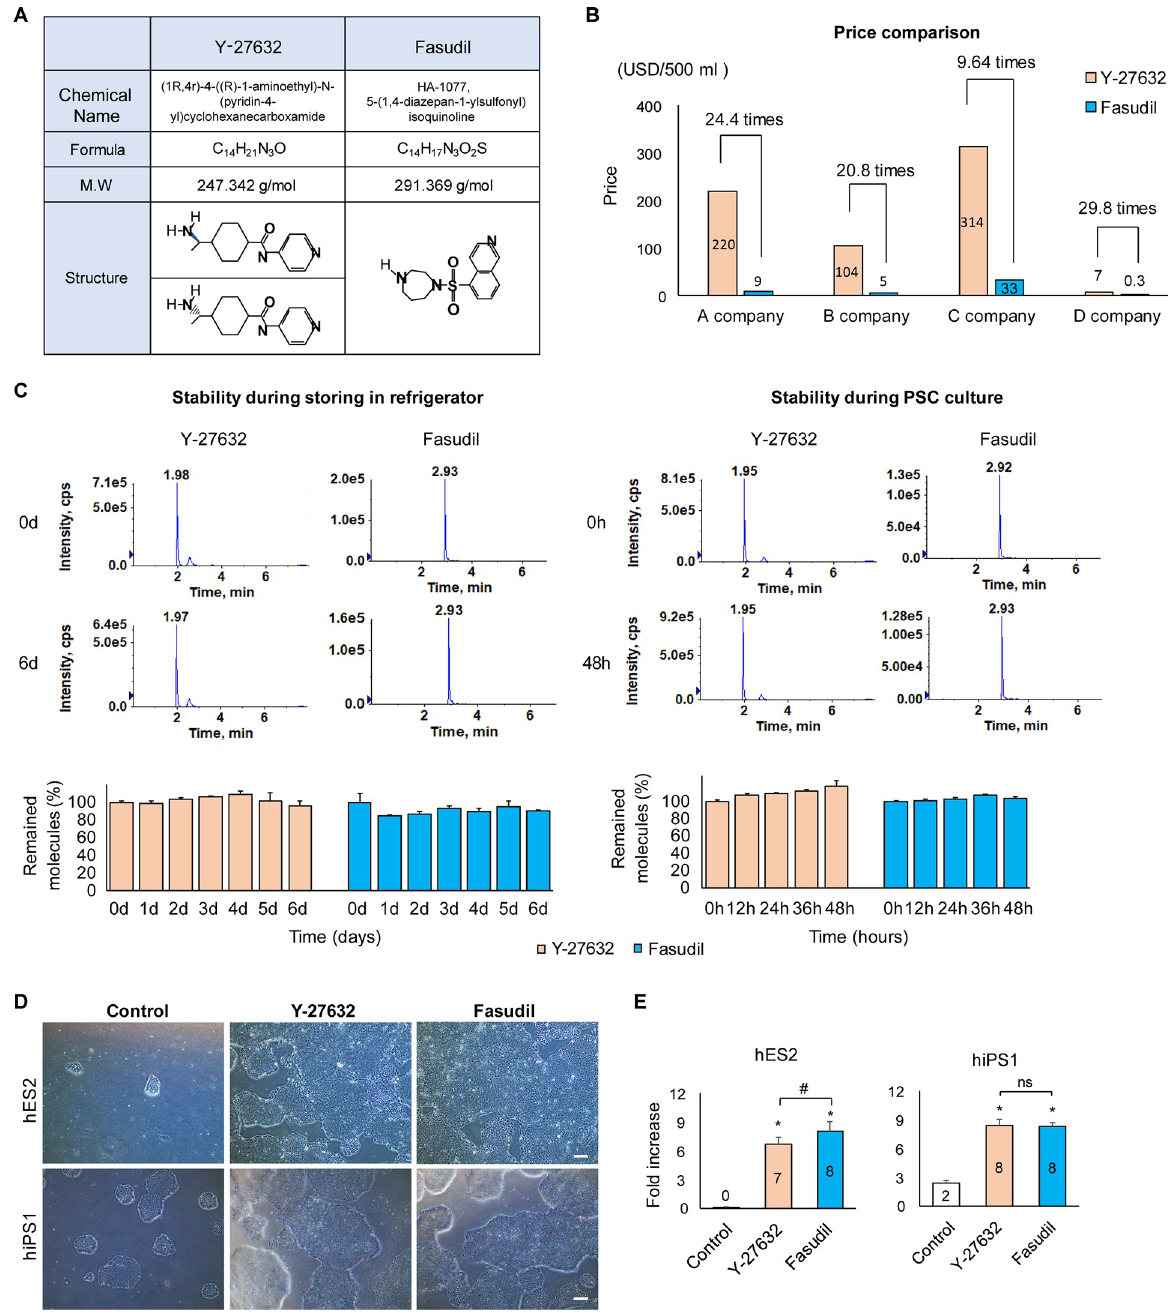
Fig 1. Molecular characteristics of fasudil and Y-27632. A: Characteristics of Y-27632 and fasudil. Y-27632 is more difficult to synthesize than fasudil. B: Price comparison of Y-27632 and fasudil. Y-27632 is 10 to 30 times more expensive than fasudil, depending on the providing company. C: Products ion mass spectrum (top) and stability comparisons (bottom) of fasudil and Y-27632 in media in the refrigerator (2–8˚C) or in PSC culture condition (5% CO 2 , 37˚C) using LC-ESI/MS/MS. The stability of fasudil was similar to that of Y-27632 (3 biological replicates). D: Typical colony morphologies of hPSCs (hES2 and hiPS1) cultured using Y-27632 or fasudil for 7 days after thawing. When treated with fasudil, colonies were larger than the control group. Scale bars = 200 μ m. E: Fold increases in Y-27632- or fasudil-supplemented cultures for 7 days after thawing. Both fasudil- and Y-27632-treatment stimulated growth ( � : p < 0.05, 3 biological replicates, 2 technical replicates). The fasudil-treated hES2 group had significantly higher growth than the Y-27632 treated group (#: p < 0.05, 3 biological replicates, 2 technical replicates). LC-ESI/MS/MS: liquid chromatography-electrospray ionization tandem mass spectrometry, hPSC: human pluripotent stem cell, hES: human embryonic stem cell, hiPS: human induced pluripotent stem